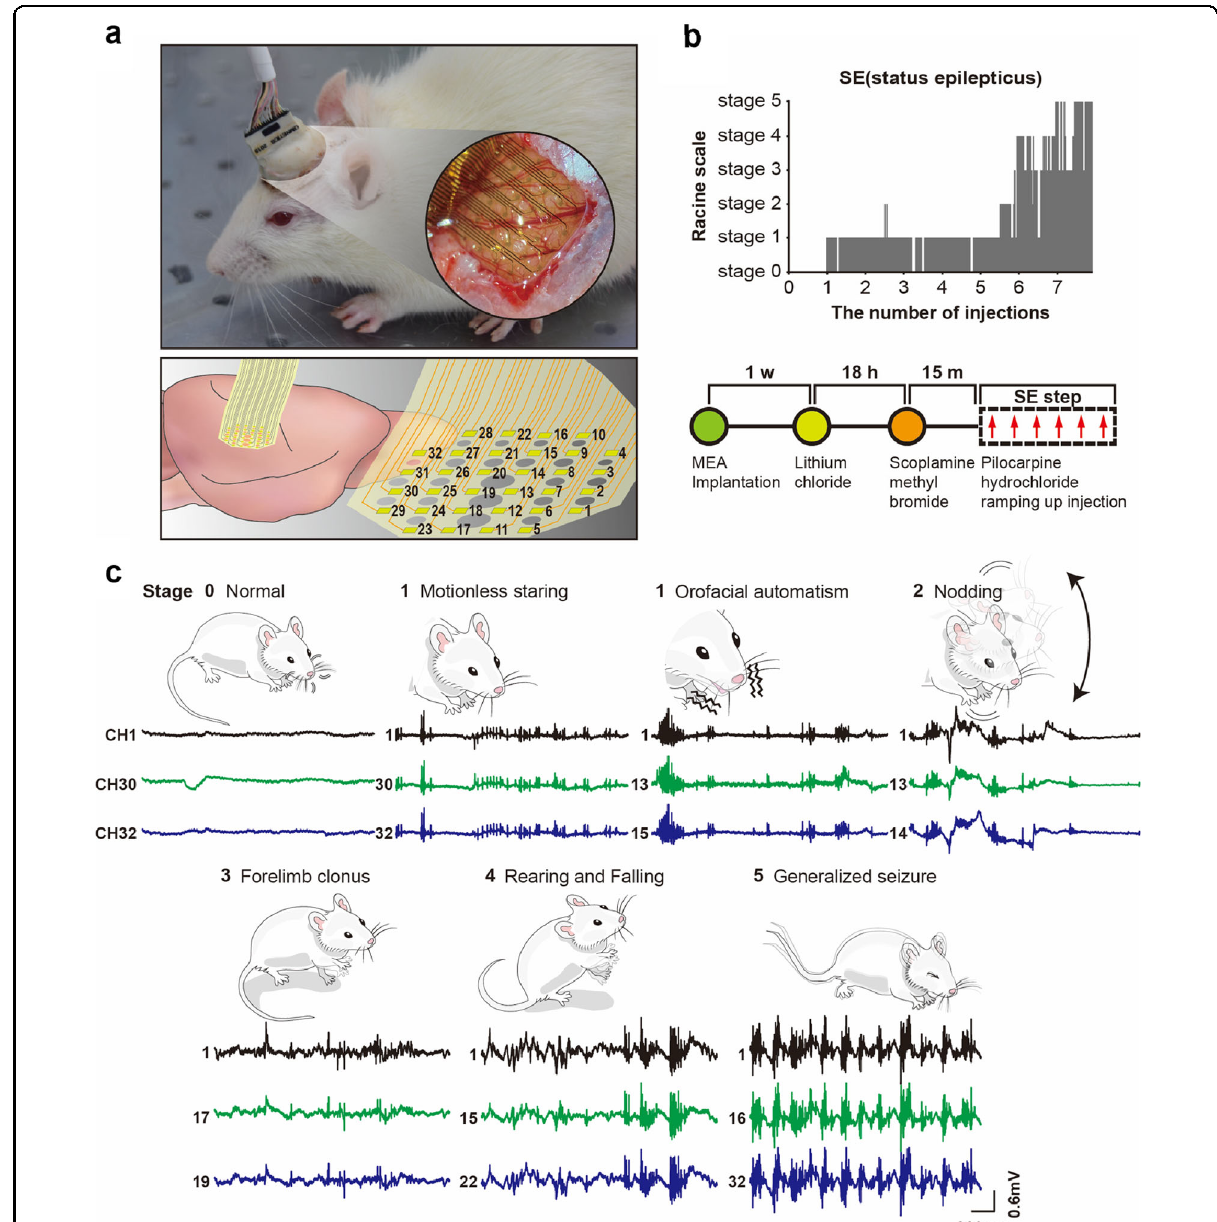
Fig. 4 Recording of SE states in a free-moving rat using a hybrid graphene multichannel electrode. a Photograph (top) and topographical design (bottom) of a hybrid graphene electrode. b Behavioral monitoring of SE stages according to Racine ’ s scale after successive injection of 10 mg/ kg of pilocarpine every 30 min (top), and a timeline of sequential experiments from hybrid graphene electrode implantation to induction of SE state (bottom). c Representative electrocorticograms at each behavior state: normal state (stage 0), motionless staring and orofacial automatism (stage 1), nodding (stage 2), forelimb clonus (stage 3), rearing and falling (stage 4), and generalized seizure (stage 5). The hybrid graphene electrode array allows concurrent observation of neural activities and behavioral changes in awake, free-moving